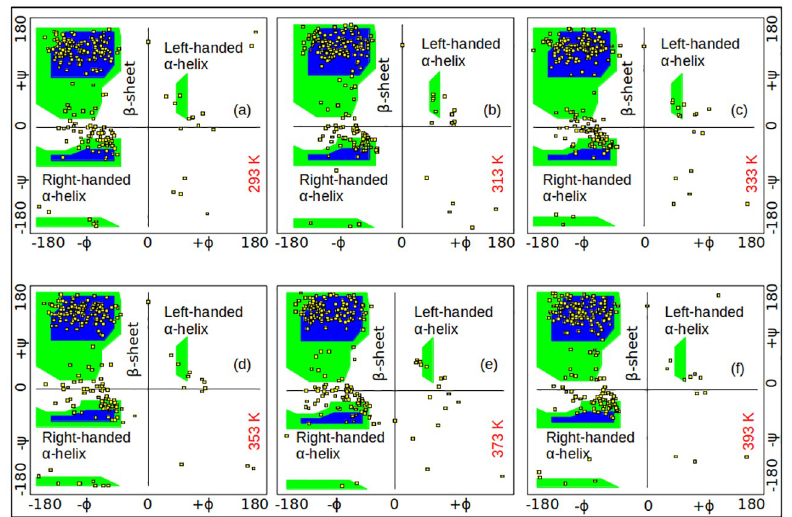
Fig 3. Ramachandran plot analysis. Ramachandran plot of simulated conformational ensembles of SazCA at different temperatures. The blue regions, green regions and white regions represent favoured, allowed and disallowed conformations, respectively. The square symbols represent the simulation data.